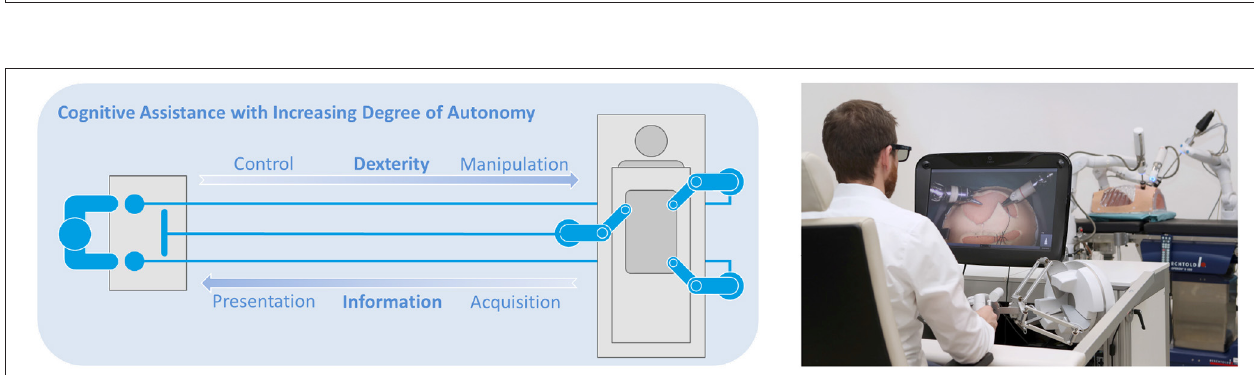
FIGURE 12 | (Left) Focus areas of surgical robotics research. (translated by permission from Springer Nature Customer Service Centre GmbH: Springer Nature, (Klodmann et al., 2020), © 2020). (Right) DLR MiroSurge research system for telemanipulation in robot-assisted laparoscopic surgery. ( © Alexandra Beier/DLR, CC BY